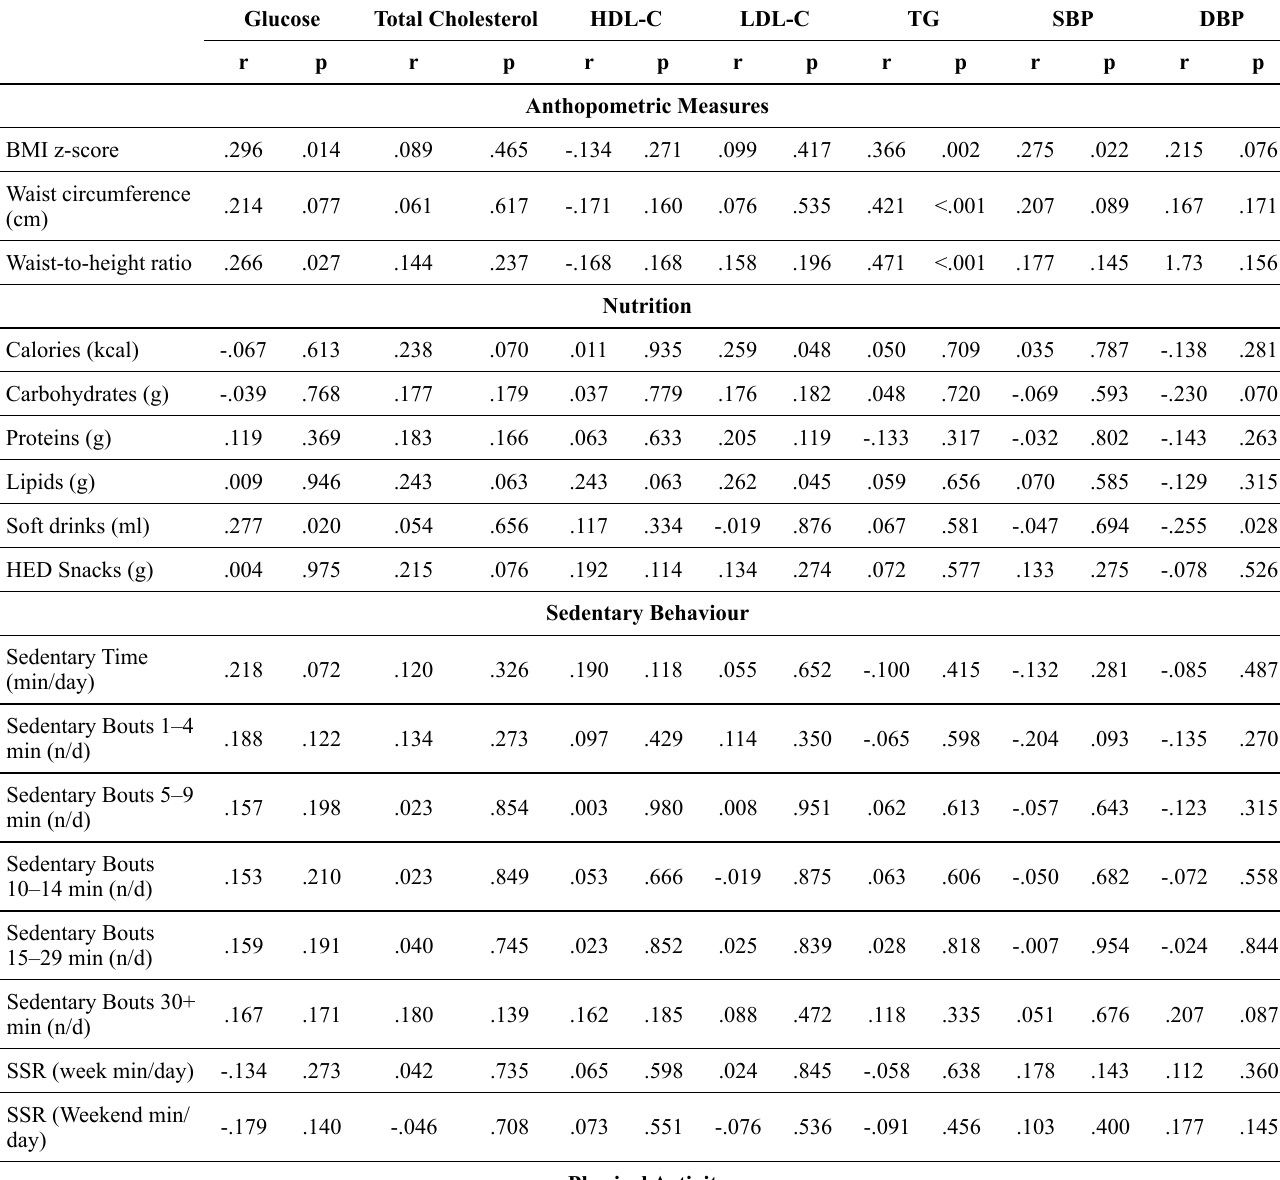
Table III. Partial correlation between blood variables and blood pressure with anthropometric variables, sedentary behaviour, physical activity, and cardiorespiratory fitness (controlled for sex, age, and socioeconomic